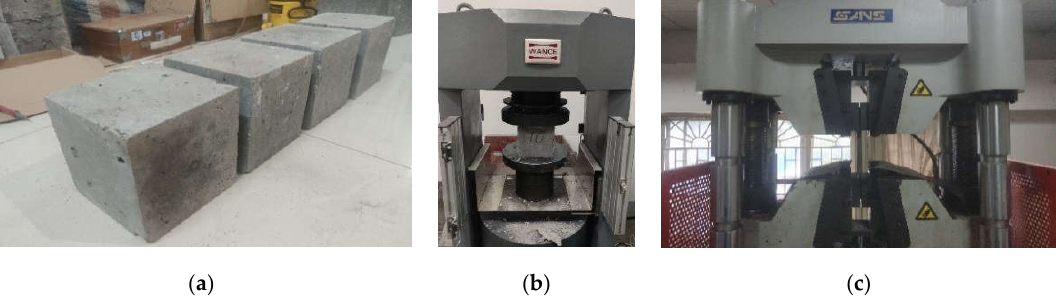
Figure 2. Specimen beams : ( a ) Before concreting; ( b ) After concreting.